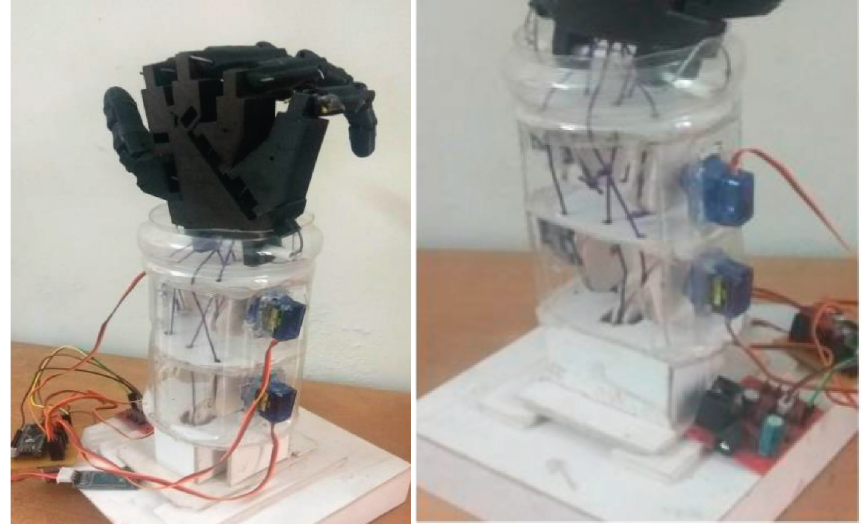
Figure 6: Pulley string